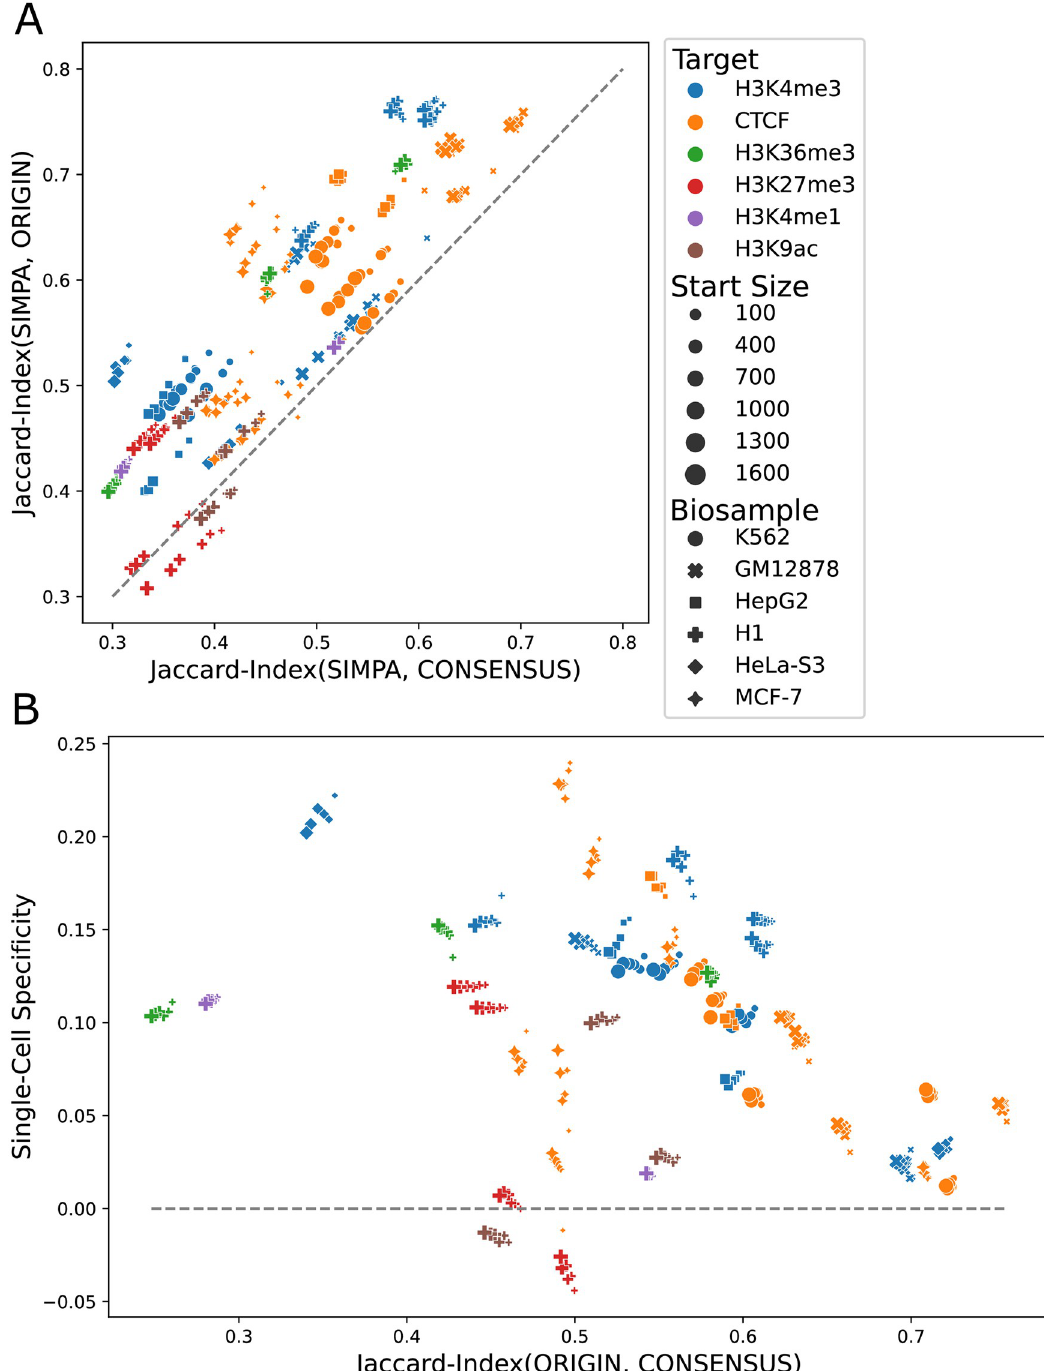
Fig 3. Single-cell specificity analysis. A . The Jaccard-Index is used to compare the imputed profiles from SIMPA with the origin human bulk profile used to create a simulated sparse profile and the consensus profile representing the remaining experiments available for the same biosample-target combination as the origin profile. The dashed line shows the balance line at which the imputed profile from SIMPA is neither closer to the origin nor to the consensus. Cases above the dashed line are those in which the imputed profile is single-cell specific, hence, closer to the origin than to the consensus. B . “Single-Cell Specificity” on the y-axis is defined as the difference between the imputed-to-origin similarity (y-axis in A ) and imputed-to-consensus similarity (x-axis in A ). Having the similarity between the origin and the consensus on the x-axis, this plot allows the visualization of the single-cell specificity in relation to how specific the origin is. The higher the similarity between the origin and consensus, the less specific is